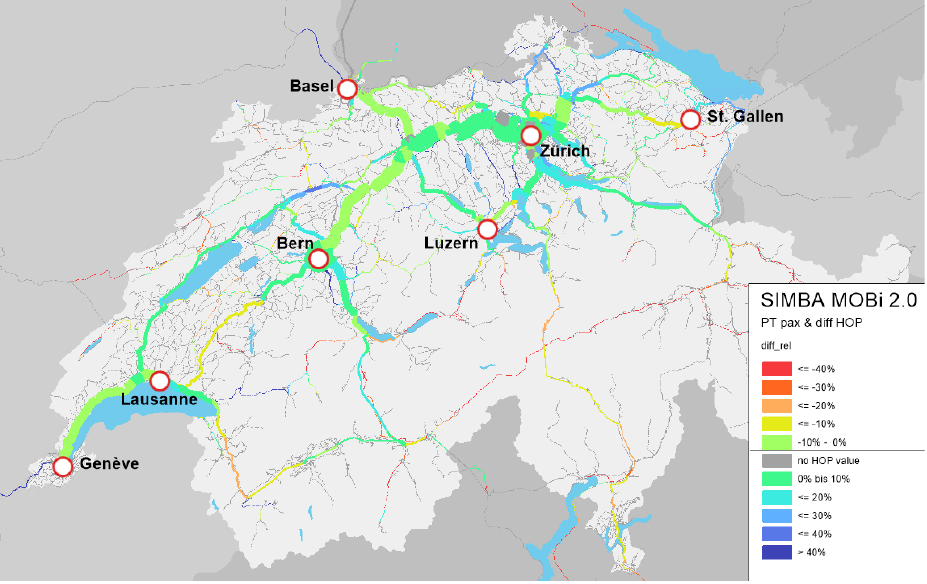
Figure 6. Rail passenger volumes – model versus counts (“HOP” represents the counts) To assess the model quality for calibration criteria consisting of numerous count data, traditional error measures like % mean absolute error (%MAE) and % root mean square error (%RMSE) were